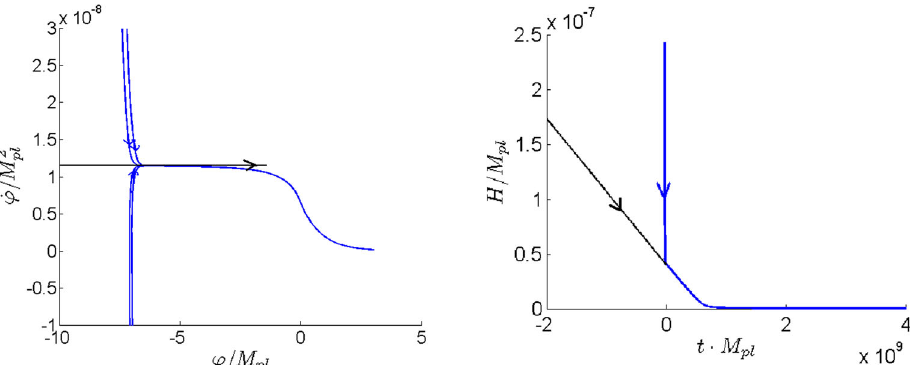
) (left) for some orbits, with the slow-roll one represented in black. Evolution of H / M pl